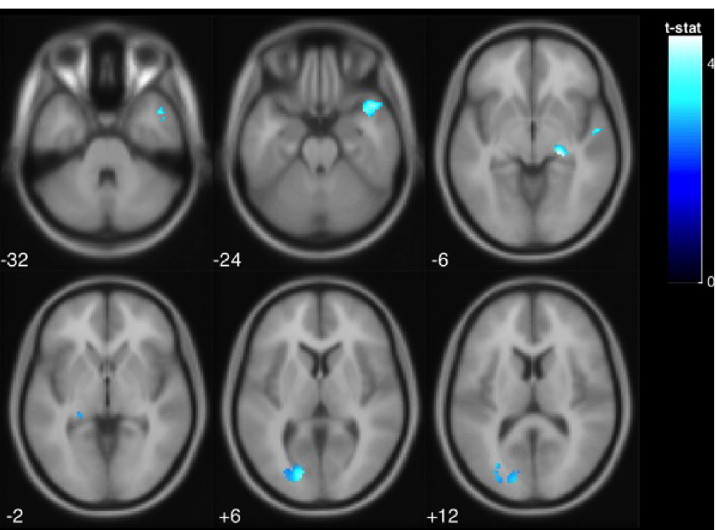
Fig 5. The intracalcarine cortex and temporal pole exhibited a positive association between age and deactivation level in the pooled young and older adults group. The colored voxels show the brain regions in which the BOLD signal was significantly decreased from rest to stimulation in a manner that was correlated with age. The shade of the color in each brain map corresponds to the t-value in the legend bar.